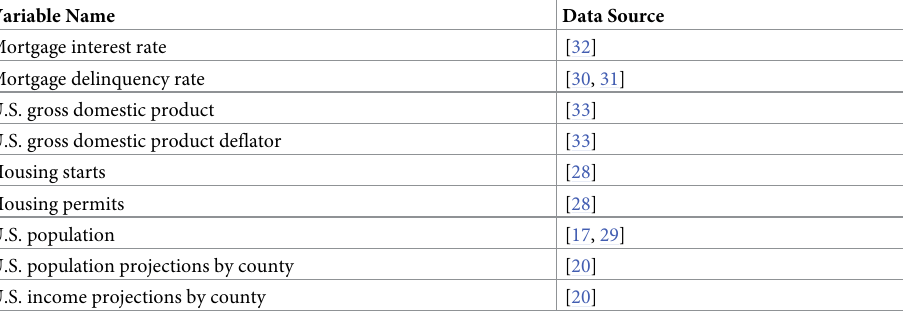
Table 1. Data sources for housing equation